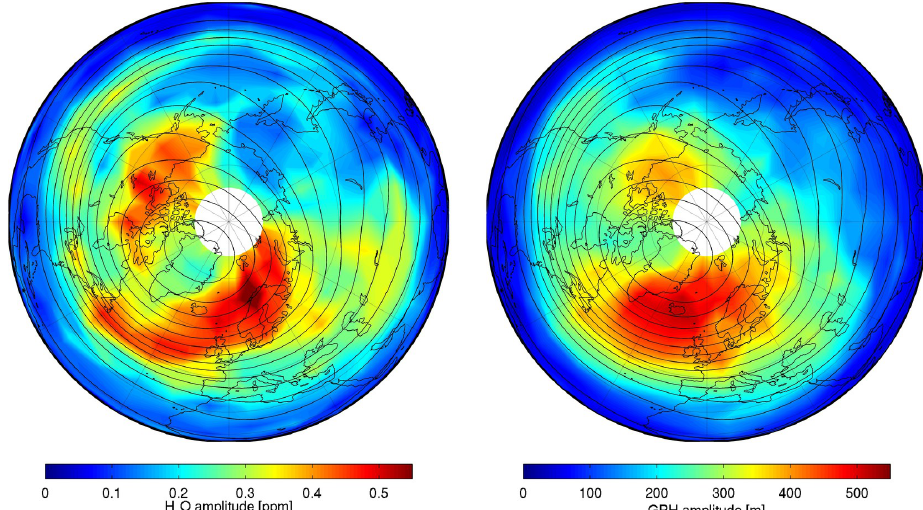
Figure 8. Hemispheric map of the amplitude of the quasi-16-day wave in water vapor (left panel) and geopotential height (right panel) on 0.05hPa as observed by Aura MLS during boreal winter 2011/2012. The amplitude is obtained by averaging the wave amplitude of the bandpass-filtered water vapor and geopotential height time series with a bandpass range from 14 to 20 days. The contour lines represent the average geopotential height on 0.05hPa between 1 December 2011 and 31 March 2012. The contour lines are equally spaced.